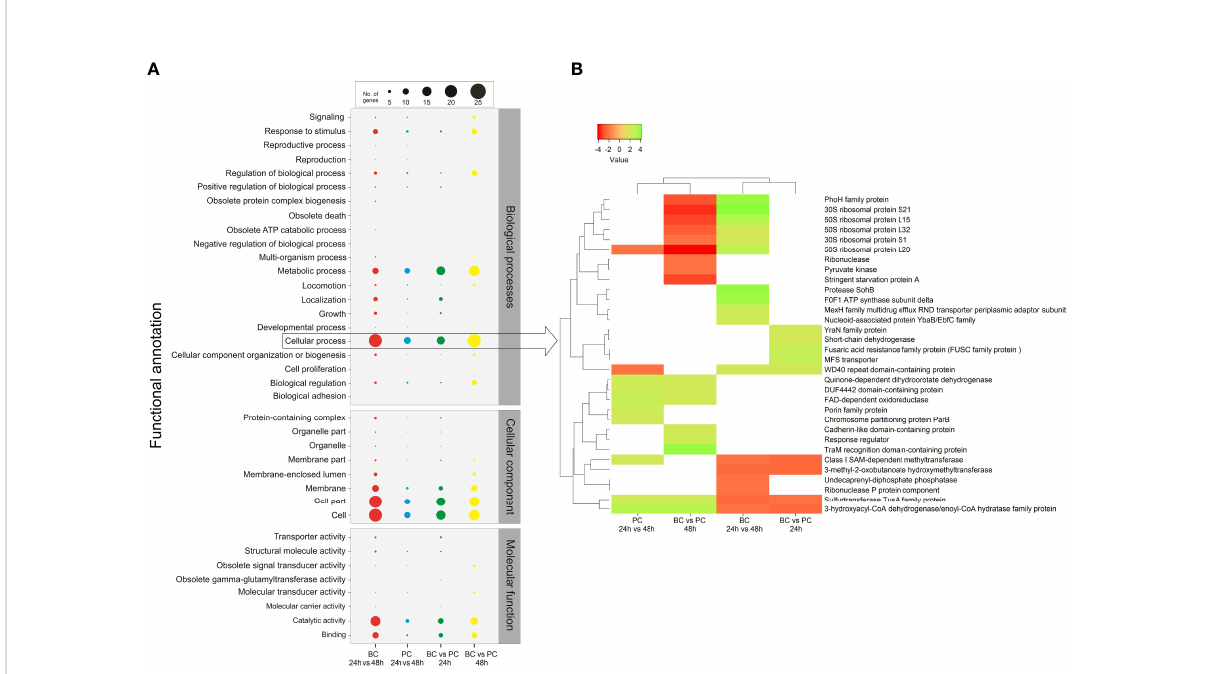
FIGURE 6 Comparative gene ontology (GO) functional classi fi cation of differentially expressed genes (DEGs) in P . salmonis LF-89 T obtained from four comparisons between different conditions. (A) The gene transcript dataset was analyzed with the WEGO tool set to second-level GO terms for the three major categories (Biological Process, Cellular Component, and Molecular Function). (B) The heatmap depicts signi fi cant DEGs between different conditions (i.e., modes of growth and/or incubation times) grouped at the ‘ Cellular process ’ GO term (see